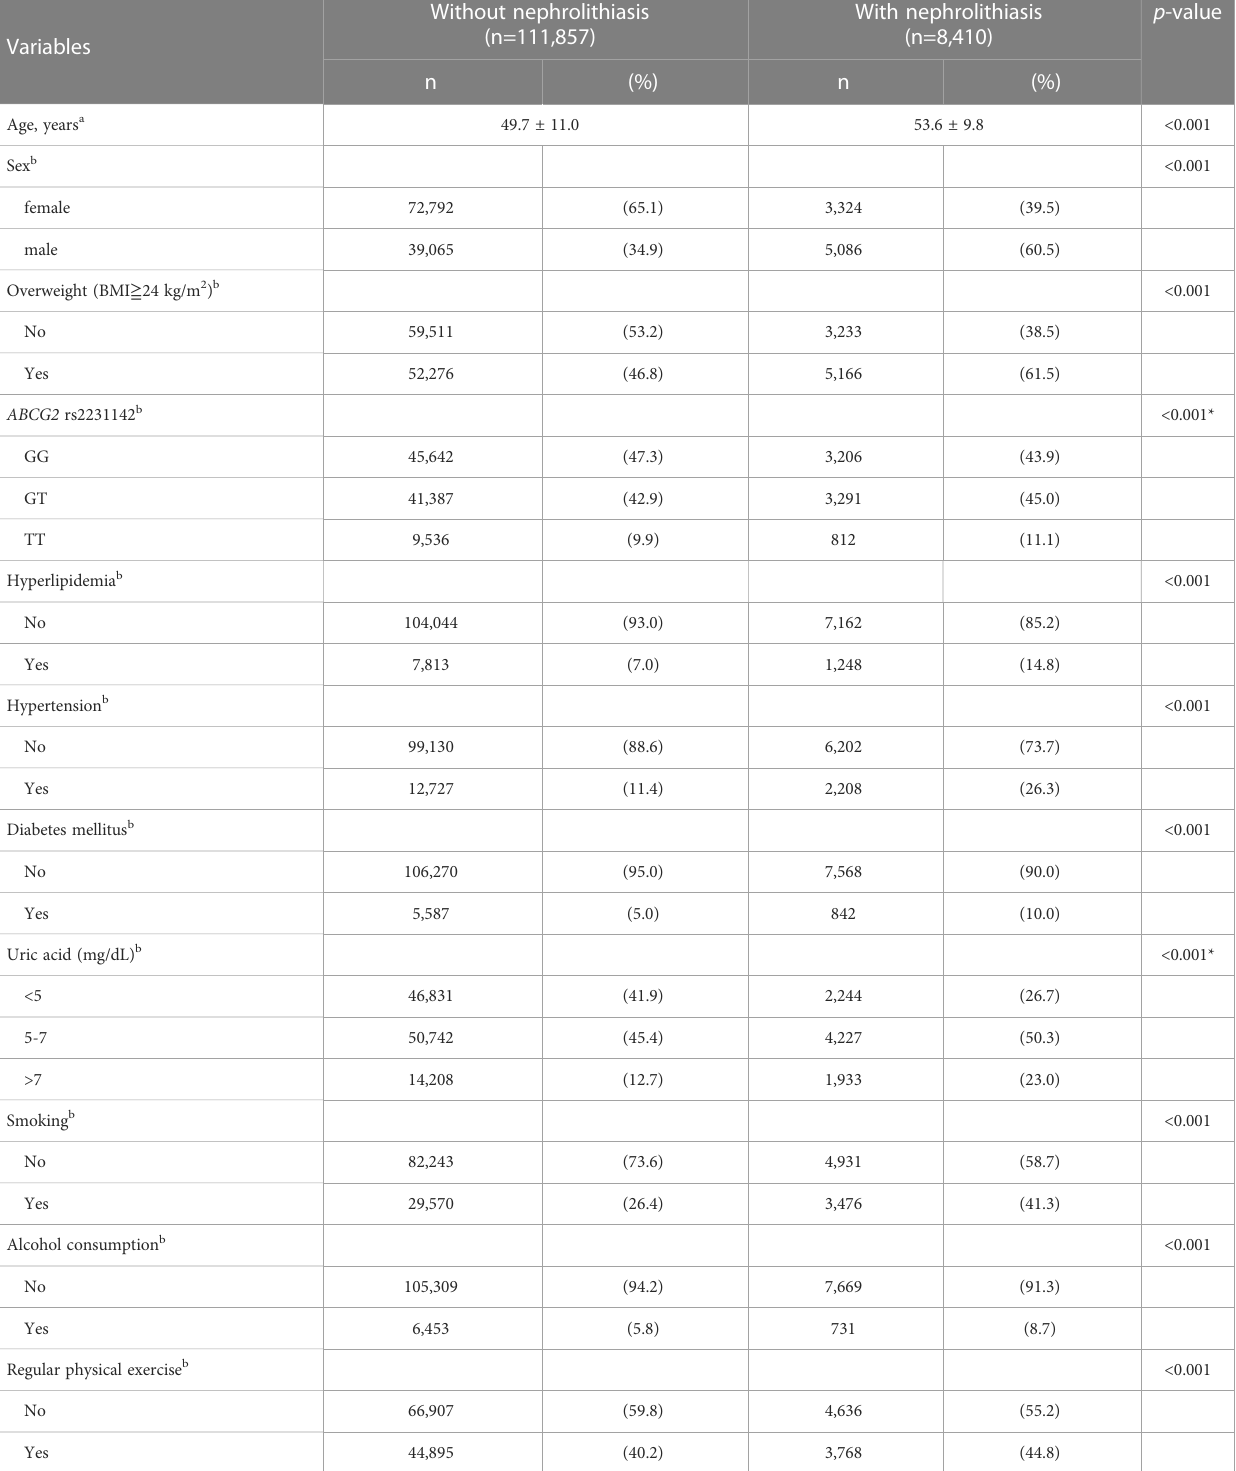
p -value Without nephrolithiasis With nephrolithiasis (n=111,857) (n=8,410) n (%) n (%)